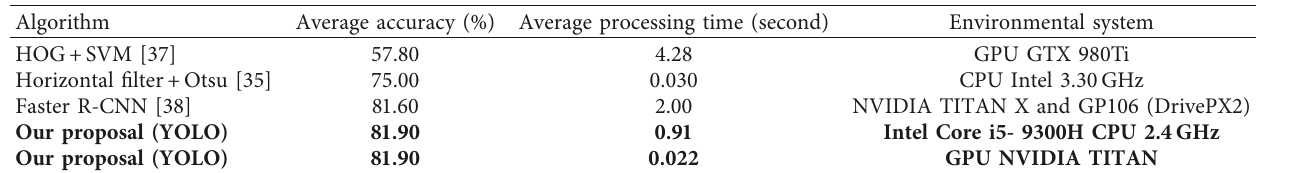
Figure 22: Result of lane detection with window sizes of (a) 100 pixels, (b) 150 pixels, (c) 200 pixels, and (d) 300 pixels in the TuSimple dataset. Table 7: Comparison of obstacle detection algorithm.